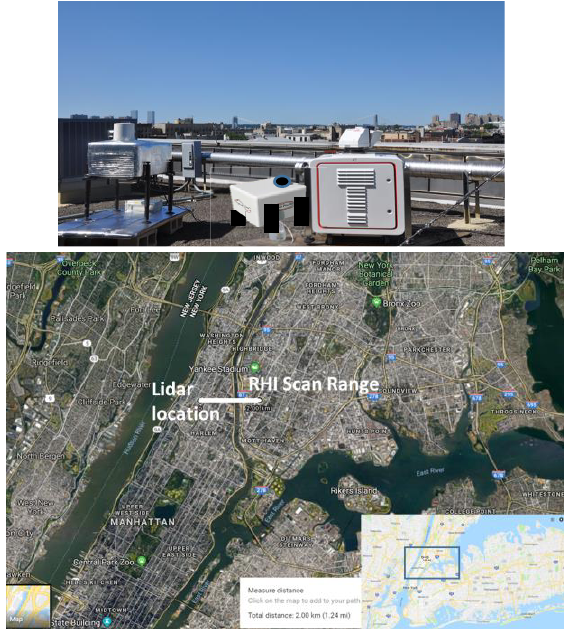
Fig. 1 Siting of Doppler Lidars in NY